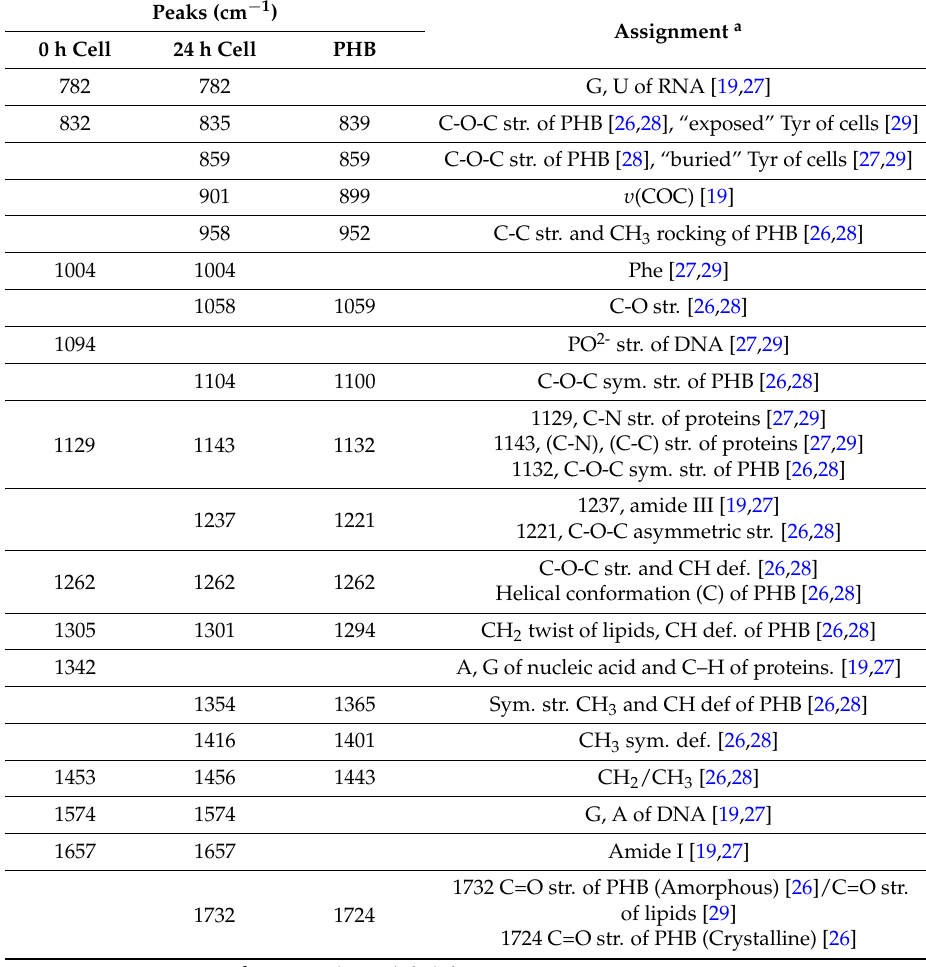
Figure 2. Raman spectra of H16 cells cultured for 0 h (curve a) and 48 h (curve b), the differential spectrum between curve b and a (curve c), and reference Raman spectrum of poly-beta-hydroxybutyrate (PHB) standard (curve d). Table 1. Tentative assignments for Raman peaks of PHB and H16